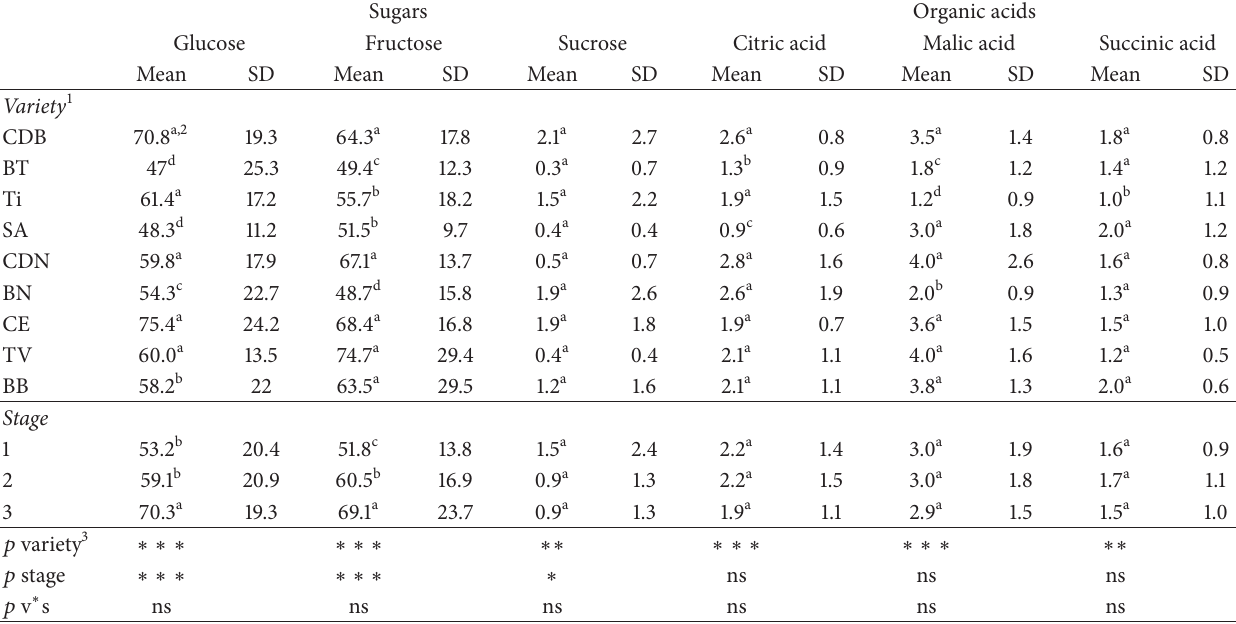
Table 3: Sugars and organic acids in flesh of the brebas according to fig tree varieties and commercial ripening stage (gkg −1 FW). Sugars Organic acids Glucose Fructose Sucrose Citric acid Malic acid Succinic